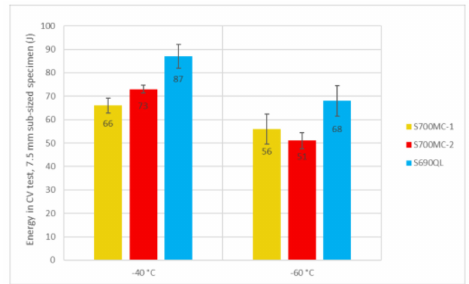
Figure 10. Charpy-V impact toughness results for the base materials. The error bars illustrate the standard deviation of the three individual